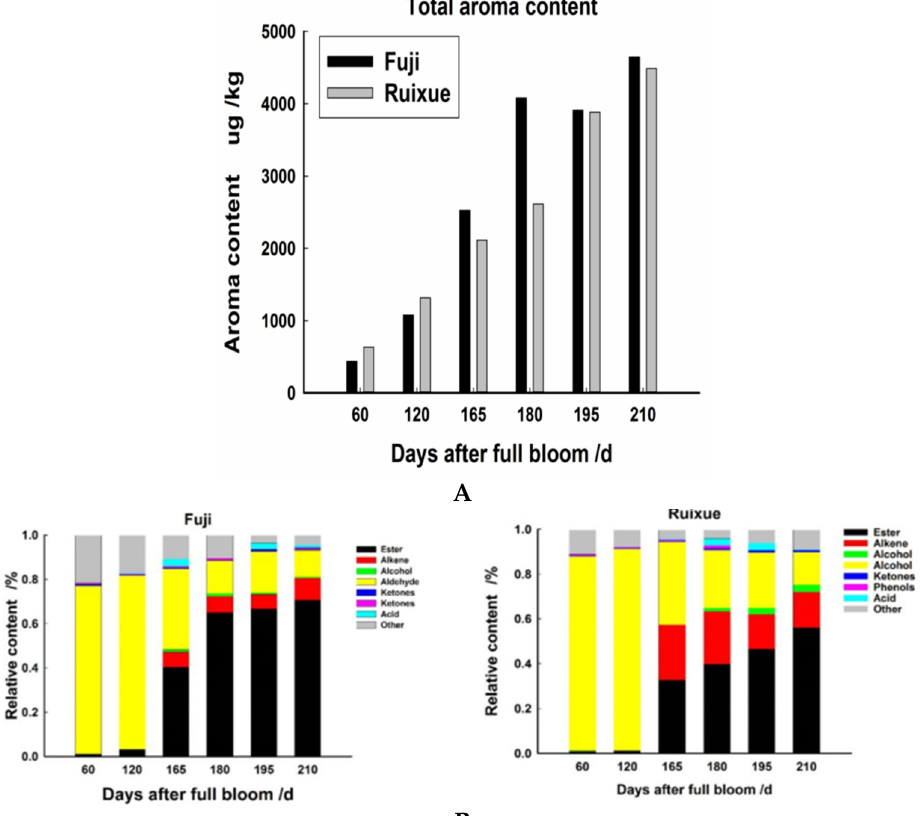
Figure 1. Quality parameters of “Ruixue” and “Fuji” apples during different stages of fruit development. ( A ) Soluble solid content; ( B ) Acidity; and ( C ) Sugar-acid ratio. Values are means ± standard error of three experimental replicates.